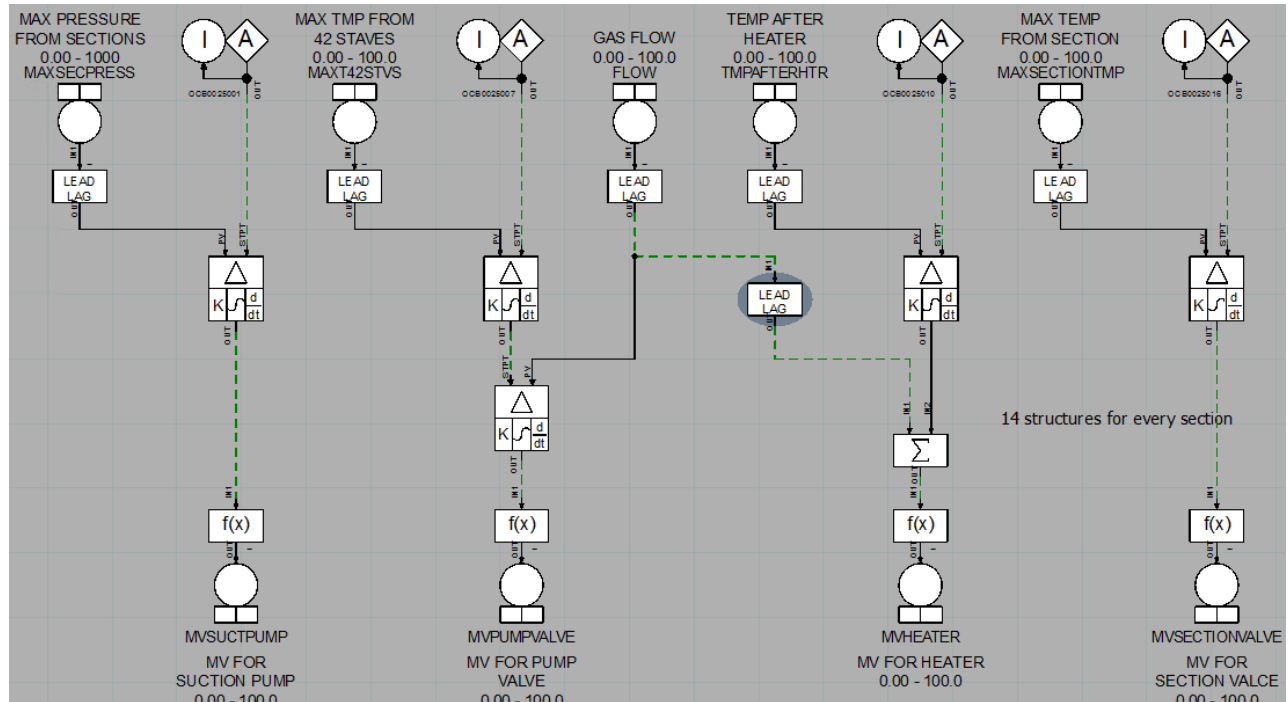
Figure 7. The thermal system: the base structure extended about feed forward.